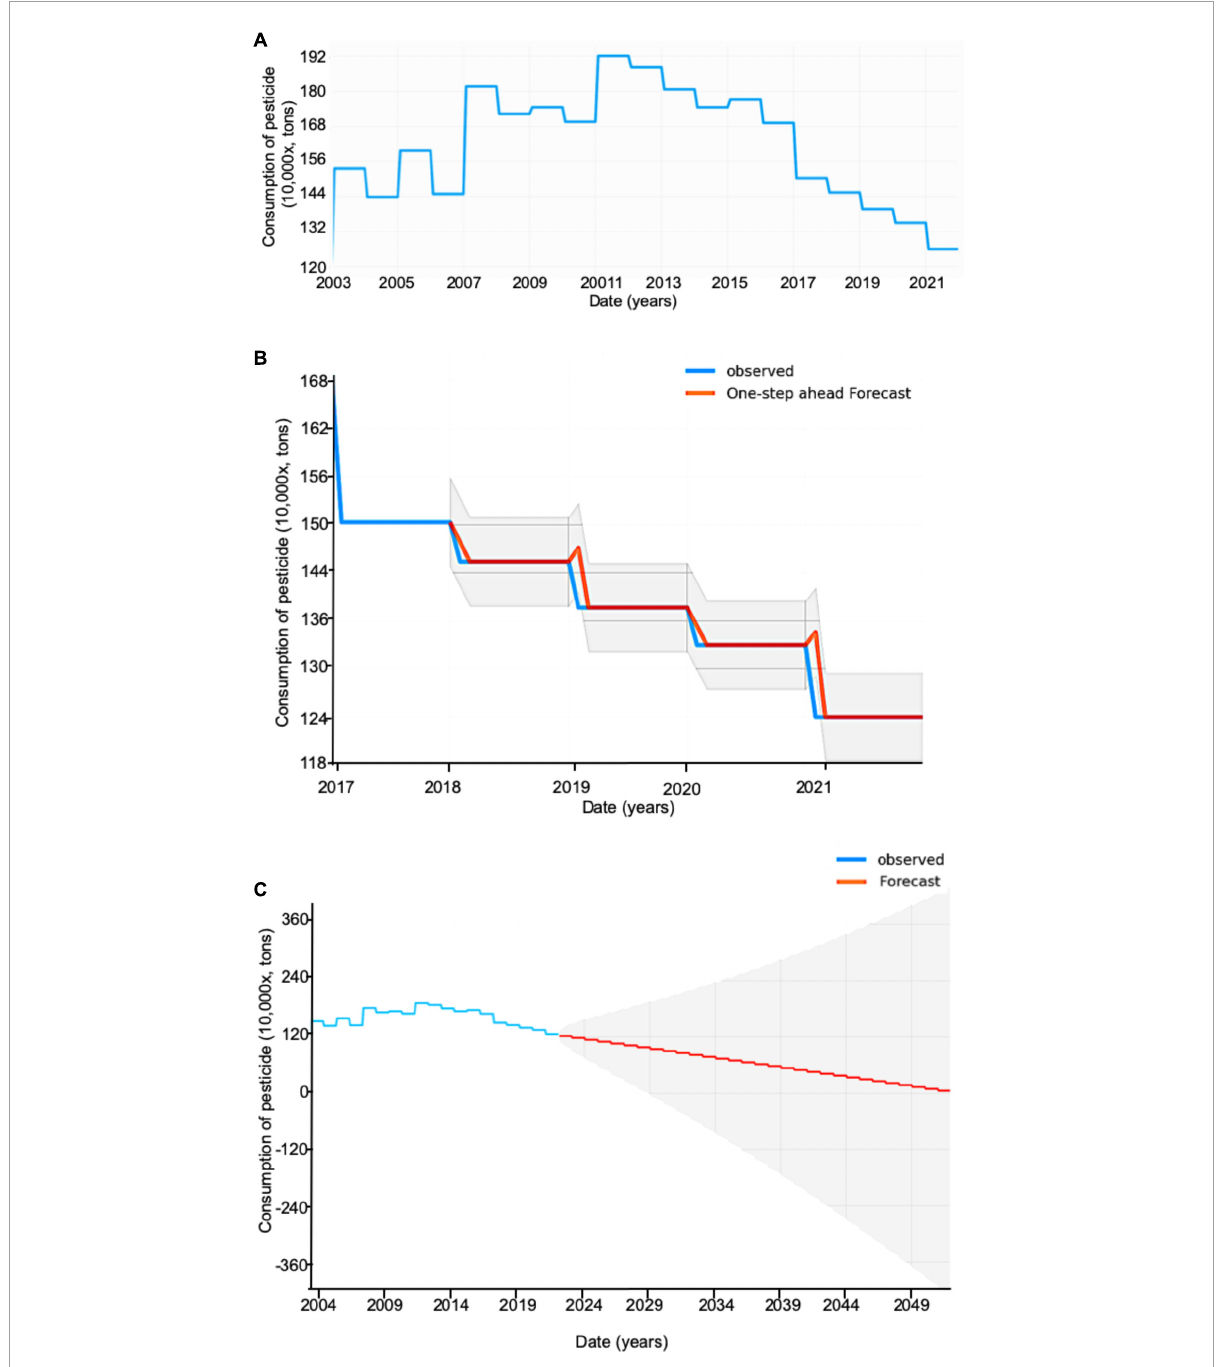
FIGURE3 A seasonal ARIMA model for time series forecasting in the chemical pesticide consumption in China in 2050. (A) The chemical pesticide consumption in China from 2003 to 2021. (B) Forecasting data are approved using the observed data. (C) The chemical pesticide consumption will reach zero by 2050 based on the seasonal ARIMA model. Gray areas indicate the observed maximum positive and negative relationship between chemical pesticide consumption and date (years). ARIMA, autoregressive integrated moving